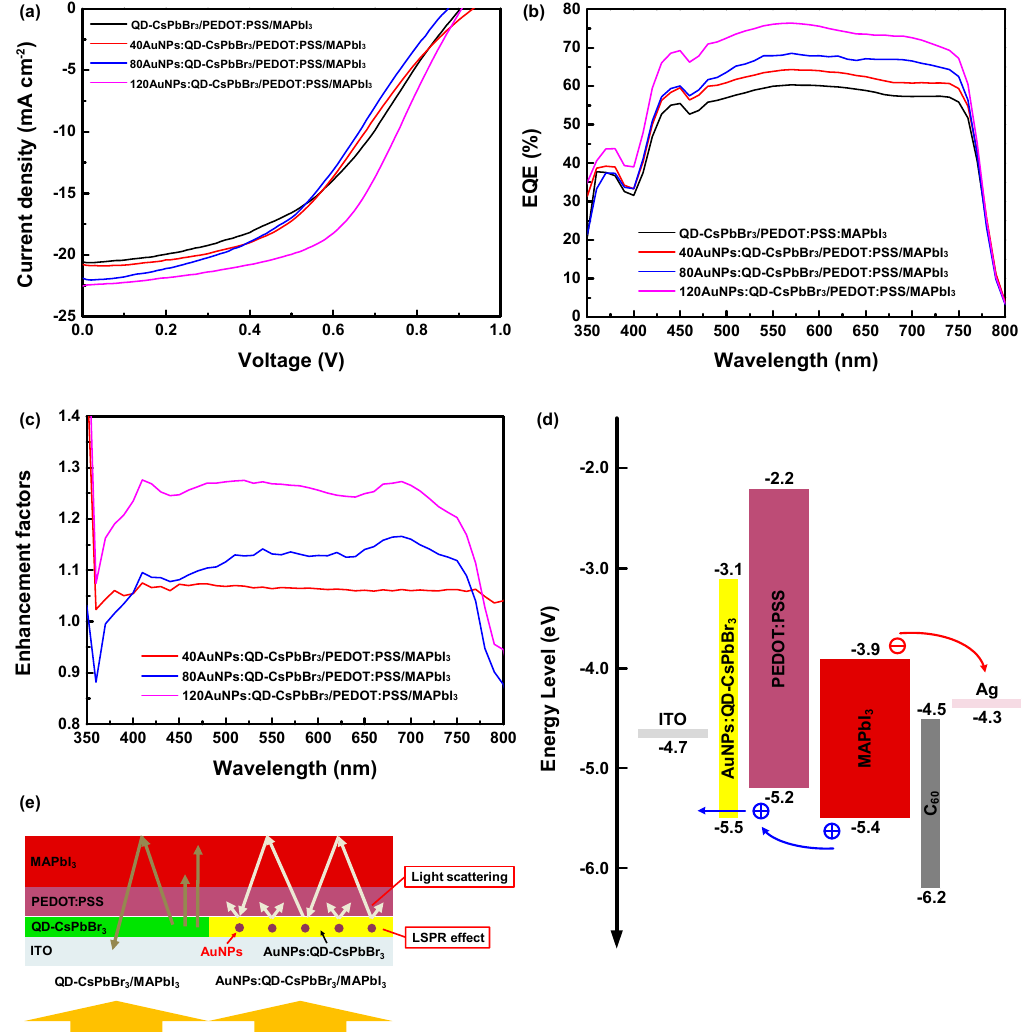
Figure 7. ( a ) Current density–voltage curve; ( b ) external quantum efficiency (EQE); ( c ) enhancement factor; ( d ) corresponding energy level diagram of each layer; ( e ) schematic diagram of the enhanced power conversion efficiency (PCE) mechanism for the plasmonic perovskite solar cells compared with that of the original cell. Table 1. Performance parameters of plasmonic perovskite solar cells with and without Au NPs. (Average value with standard deviation from 20 devices).